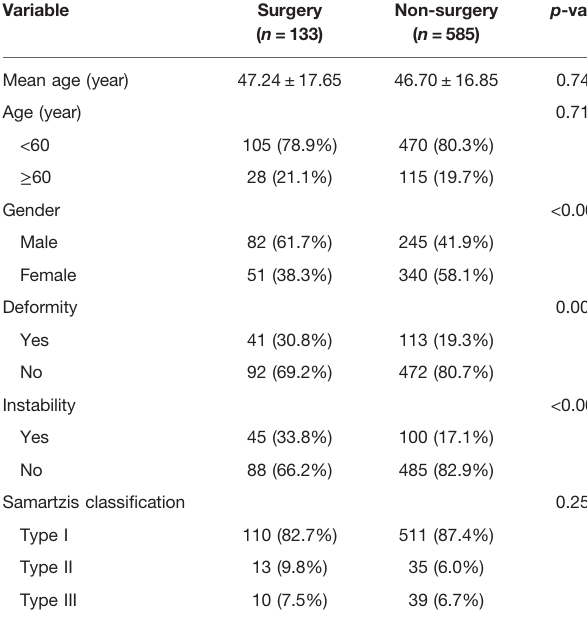
TABLE 6 | Comparison of patients with or without surgical